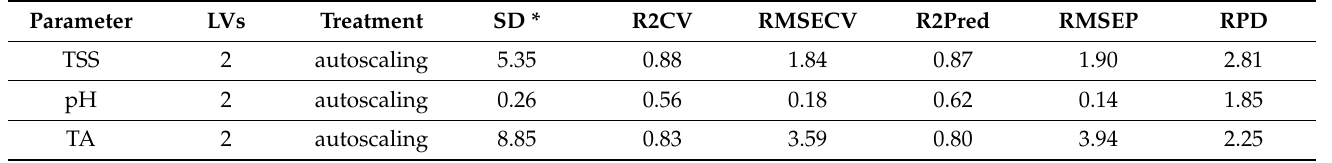
Table 2. Figure of merit of the partial least square (PLS) models calculated with two latent variables, using optical data pretreated with autoscaling.